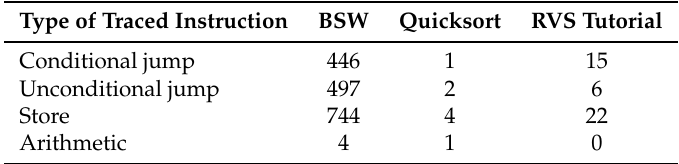
Table 4. “Tracing patterns” obtained from the static analysis of BSW, Quicksort and RVS tutorial tests. Type of Traced Instruction BSW